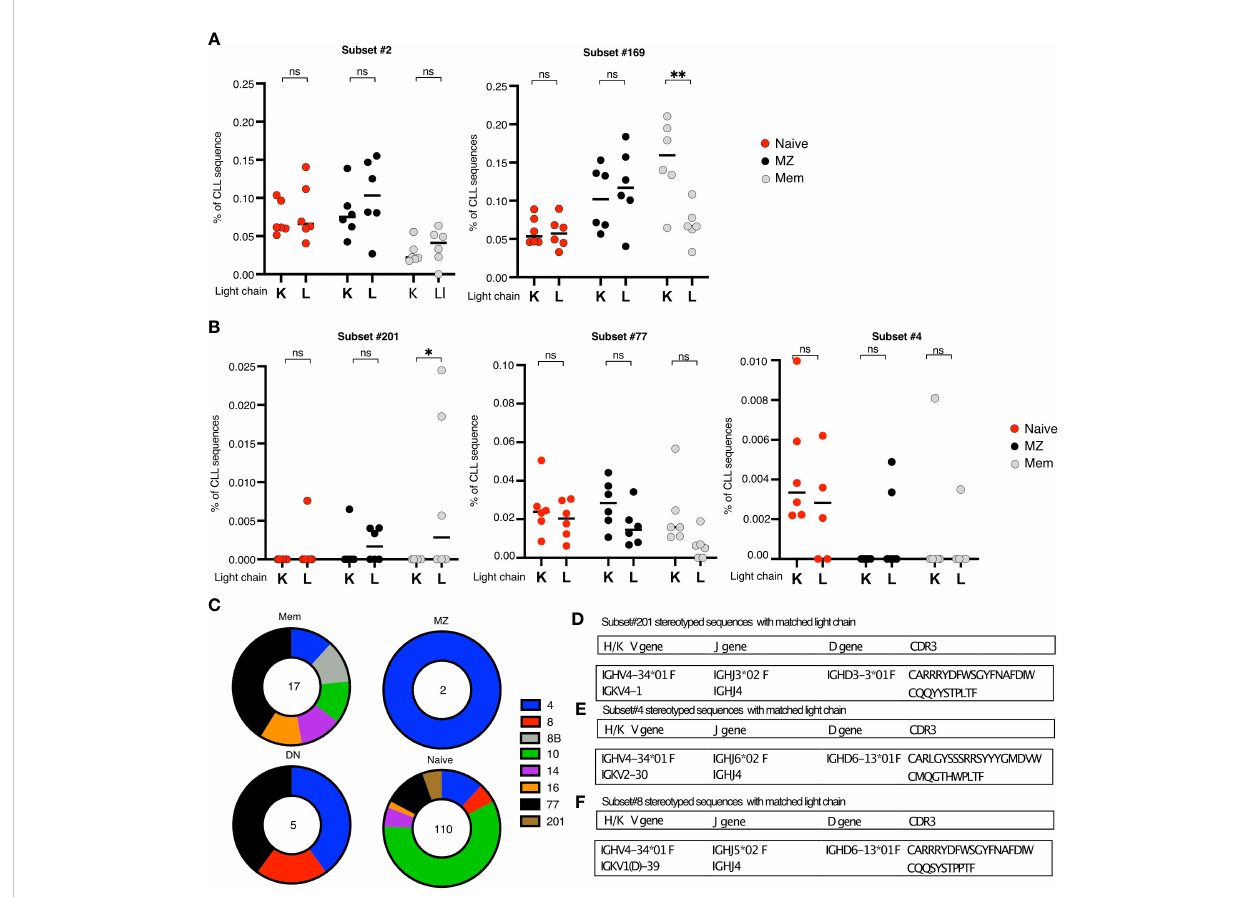
FIGURE 7 (A, B) Summary plots comparing the mean frequencies of CLL-SLS in the IG k and IG l fractions of the indicated B cell populations. Each plot refers to a particular CLL subsets. Statistical analysis and multiple comparisons were performed with Anova, Holm-Sidak test. (C) Pie charts of the frequency distribution of the CLL-SLS found after single cell RNA sequencing of the indicated B cell population. Each pie slice identi fi es a speci fi c satellite subset following the color code in the legend. (D-F) Table of features of IGHV and matching IGK/LV attributed to (D) . subset #201;